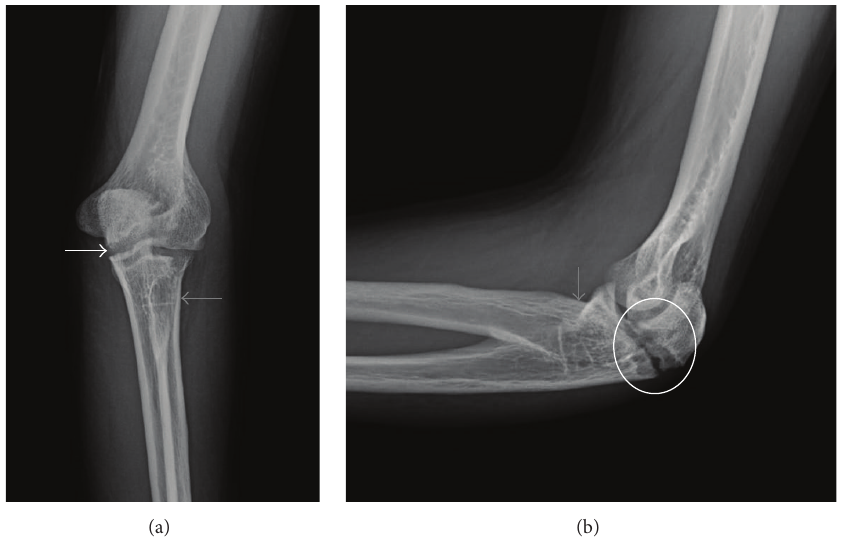
Figure 4: Young adult male with history of Rothmund-Thomson syndrome diagnosed at 2 years of age. Findings: (a) mildly displaced fracture through the olecranon (white arrow). There is congenital fusion of radial head and proximal ulna (grey arrow). (b) The mildly displaced olecranon is better appreciated on the lateral radiograph. There is osteolysis and cortication along the fracture margins (oval), which raised the concern for underlying lytic bone lesion. Congenital fusion of the radial head and ulna is again noted (grey arrow). Technique: (a) AP radiograph kVp = 65, mAs = 4, and (b) Lateral radiograph kVp = 65, mAs =